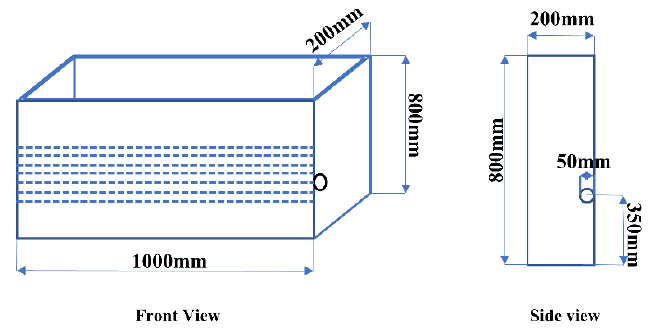
Figure 1. Schematic of the model box.